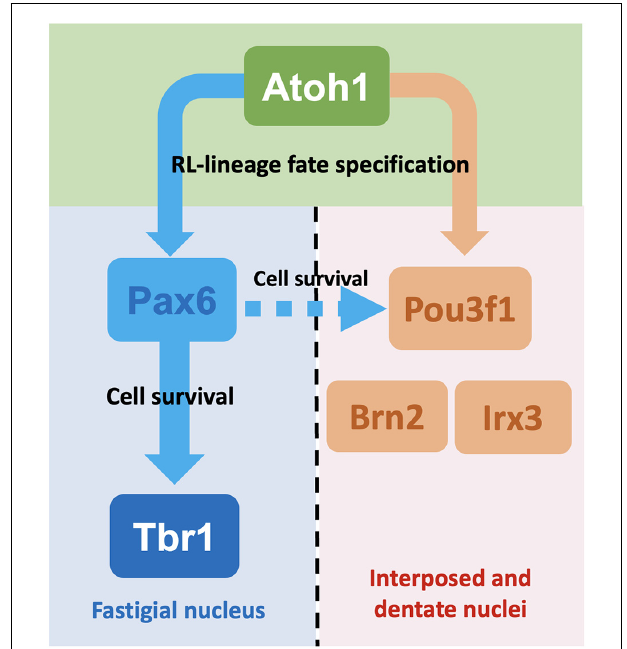
FIGURE 10 | Summary schematic showing the major findings of this article. Following the expression of Atoh1, glutamatergic CN neurons undergo specification into either the fastigial/medial CN neurons or the interposed and dentate/lateral CN neurons. This process of specification depends on the expression of disparate sets of transcription factors. For glutamatergic CN neurons destined to settle in the fastigial nucleus, these cells subsequently express Pax6 then Tbr1. On the other hand, those destined to settle in the interposed and dentate nuclei express Pou3f1, a subset of which also expresses Brn2 or Irx3. Although different sets of molecules are expressed, the two cohorts of glutamatergic CN neurons also demonstrate cross-talk, as some Pou3f1 + cells do require Pax6 for their survival, as indicated by the dashed